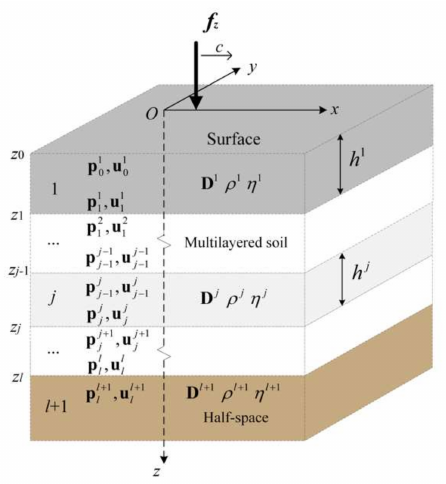
Figure 1. Computational model of the multilayered